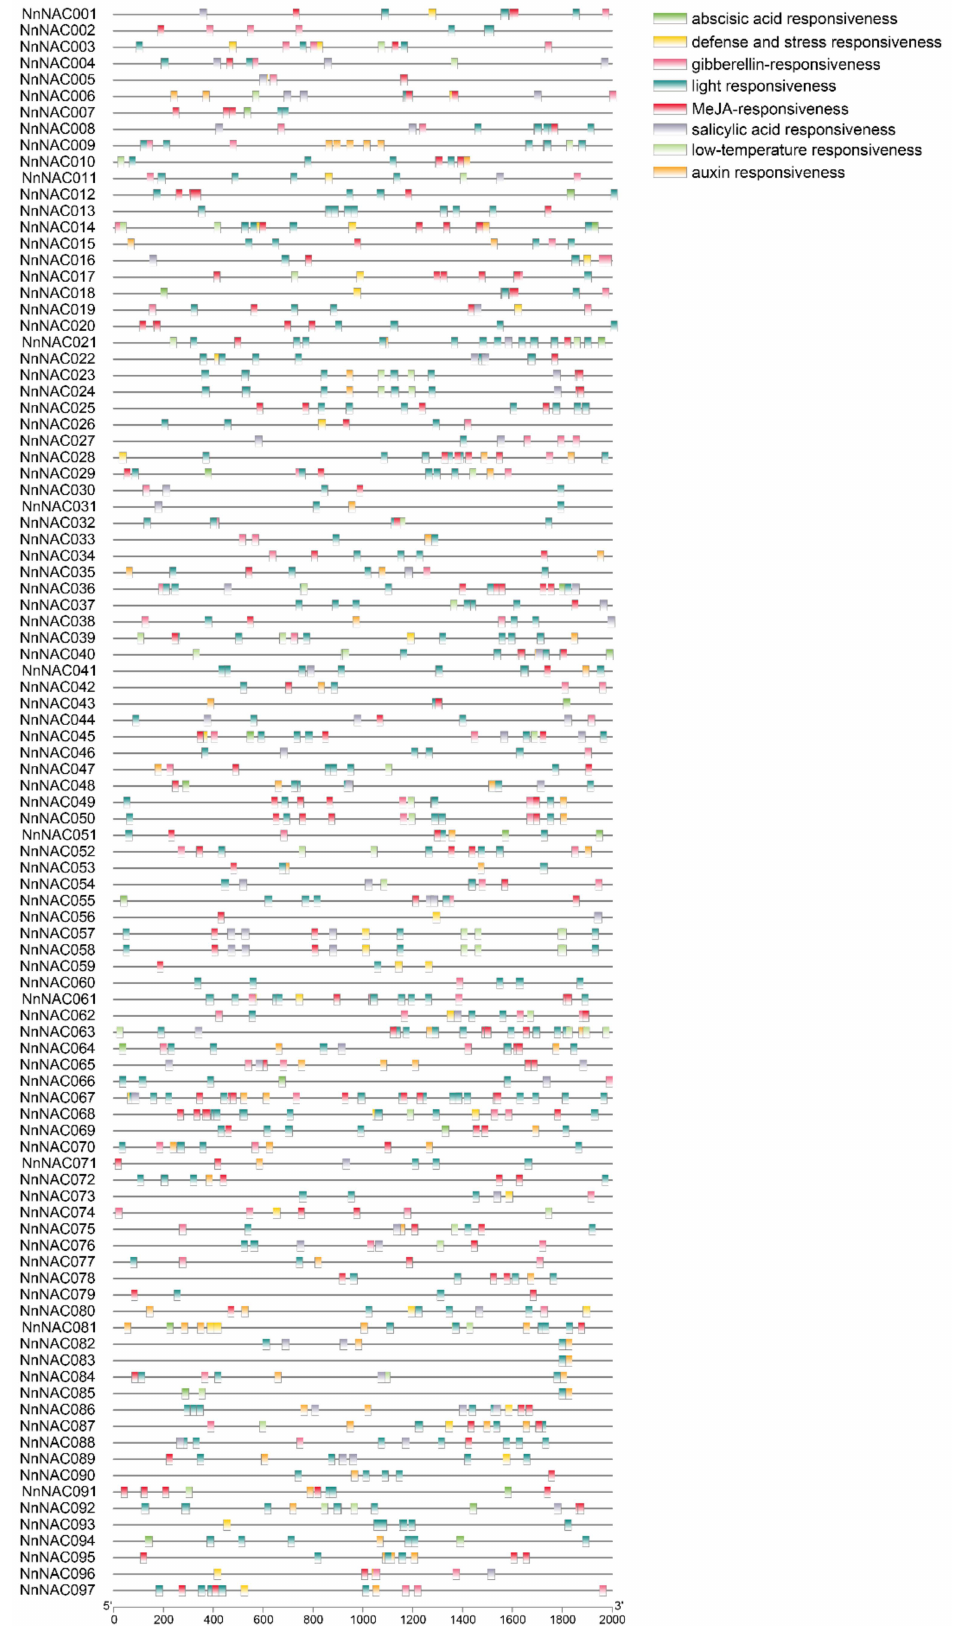
Figure 4. The cis-acting elements in the promoters of soybean SRS